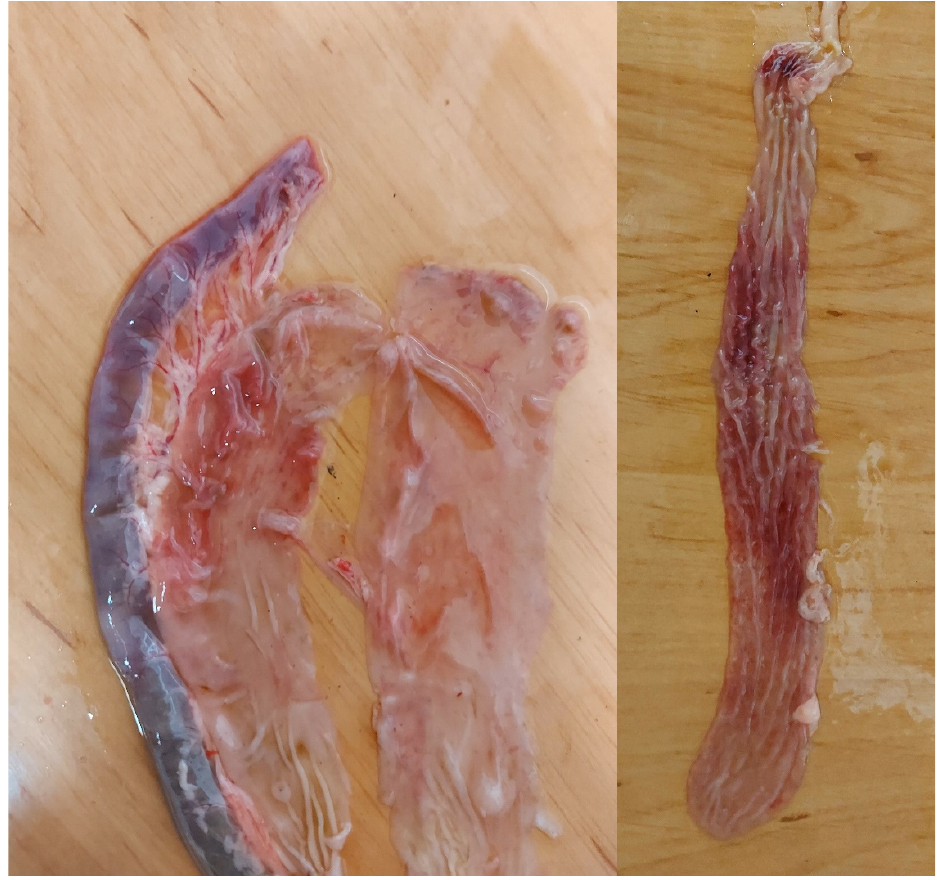
Figure 2. The pathological findings in ceca of E. tenella infected broiler chickens. Gross appearance of ceca showing thickening of the intestinal wall and congestion.